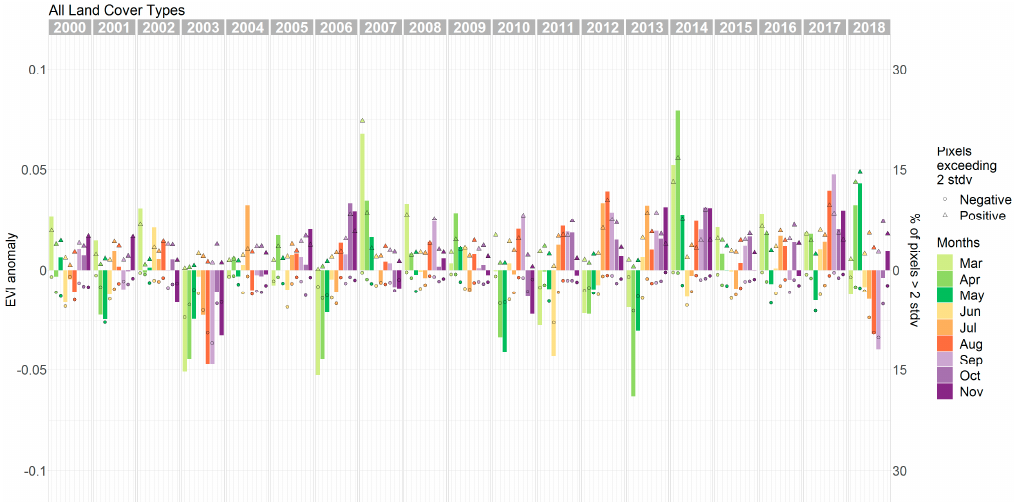
Figure 4. Monthly averaged EVI anomalies for all vegetated land cover types and percentage of pixels with EVI deviances exceeding two standard deviations (pixel-based) positively and negatively per month for Germany for the years 2000–2018 for all vegetated land cover types.